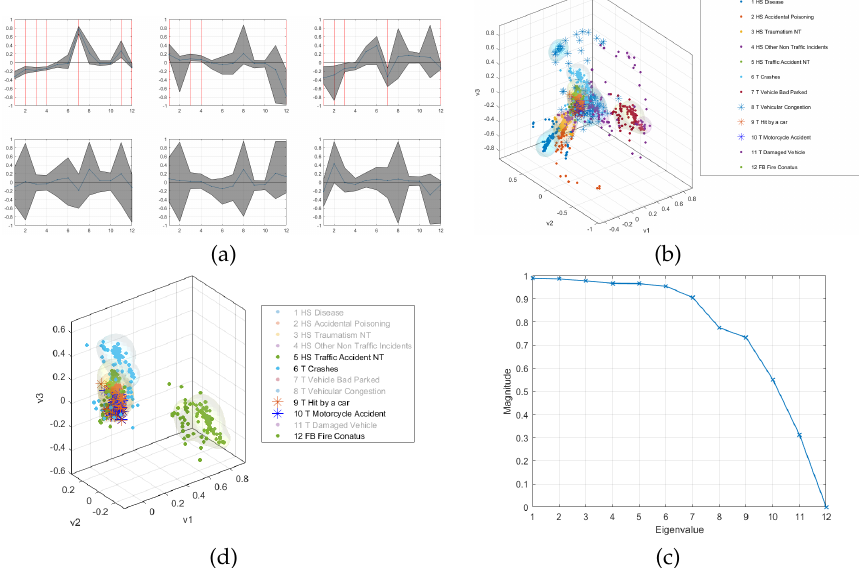
Figure 9. Combined emergencies of health services, transit, and fire brigades: ( a ) Eigenvectors; ( b ) All the visible categories; ( c ) Only five categories visible, with two concentrations well defined (health services and transit) separated from fire brigades; ( d ) Eigenvalues and relative relevance of the